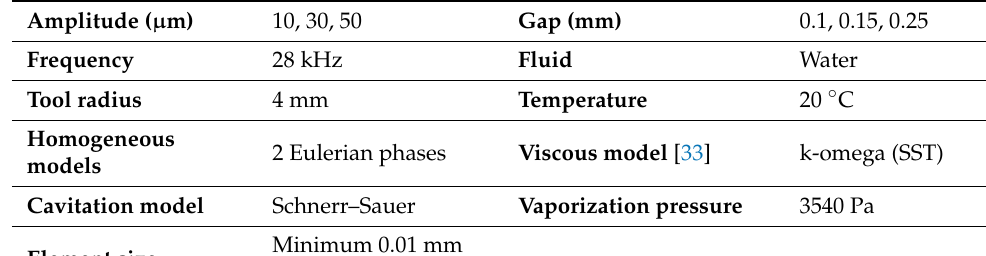
Figure 2. ( a ) FEA mesh model and the ( b ) velocity and ( c ) pressure distributions (gap = 0.25 mm, amplitude = 30 μ m).